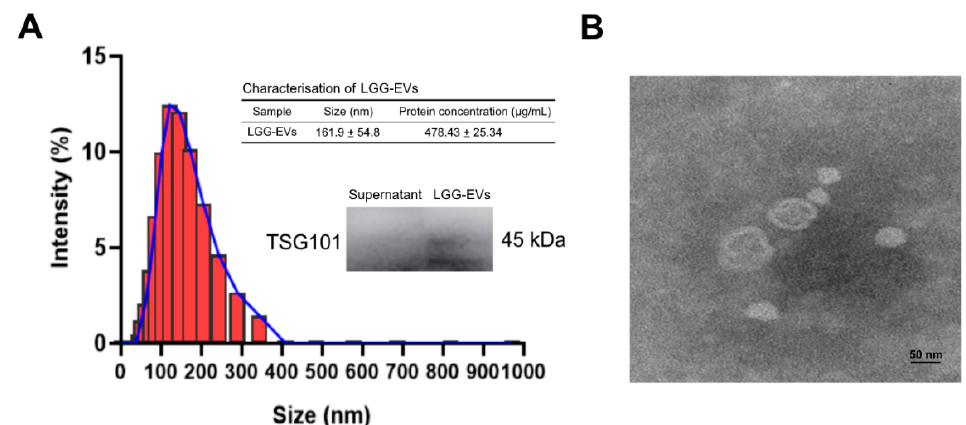
Figure 1. Characterization of L. rhamnosus GG-derived EVs. ( A ) Size distribution of LGG-EVs ( Lactobacillus rhamnosus GG derived extracellular vesicles) was measured by DLS (Dynamic Light Scattering). The peak diameter was about 150 nm. Immunoblot bands demonstrating the presence of TSG101 (Tumor susceptibility gene 101) marker in LGG-EVs. ( B ) Transmission electron microscopy images of isolated LGG-EVs. Scale bar, 50 nm.